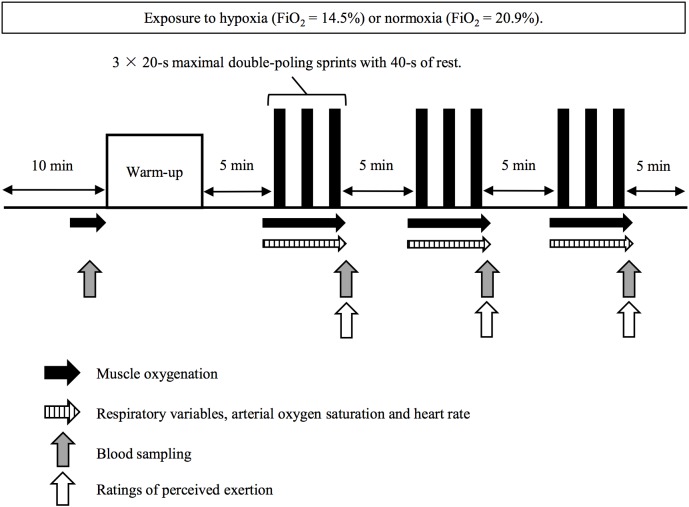
Protocol overview.